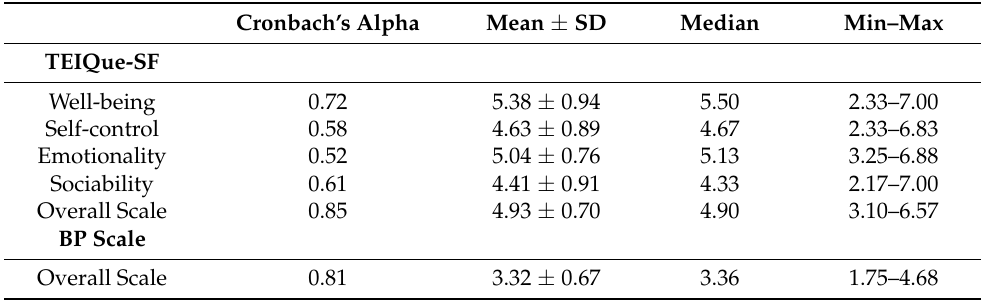
Table 2. Trait Emotional Intelligence Questionnaire-Short Form (TEIQue-SF) and Boredom Proneness Scale (BPS) of the Nurses ( n =